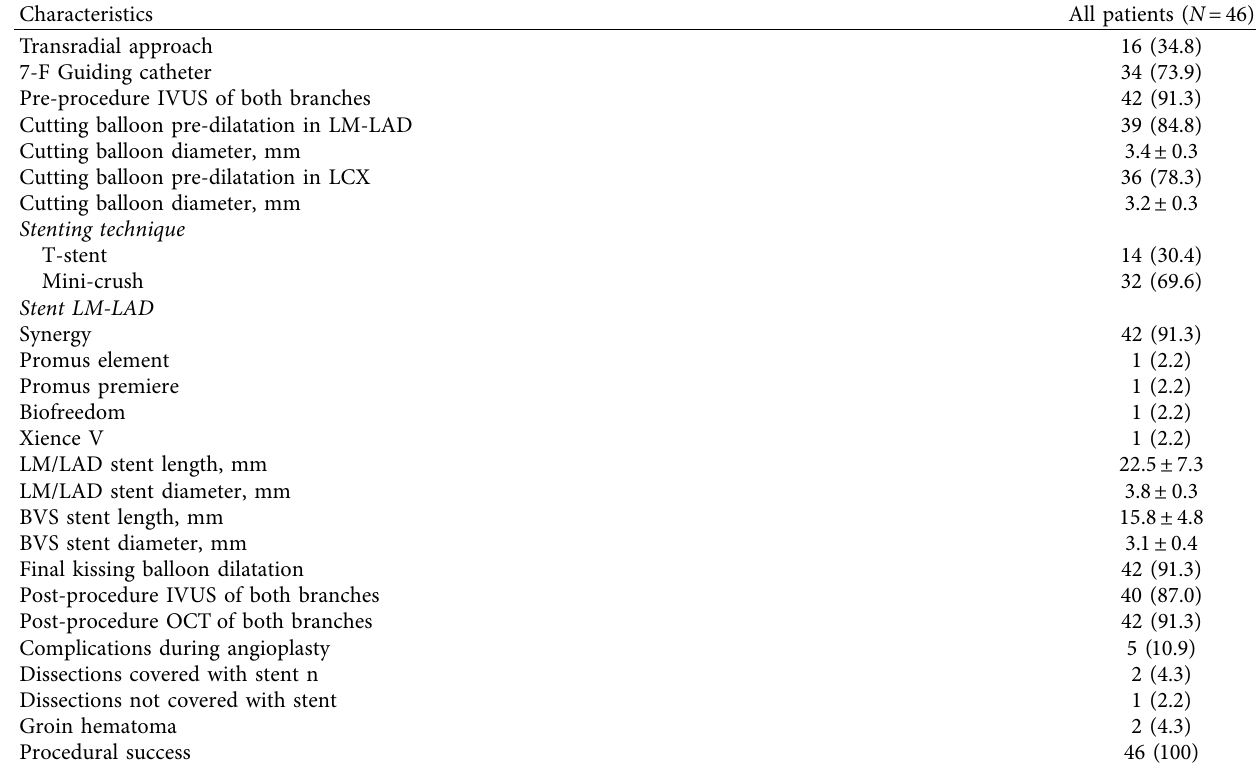
Table 2: Procedural characteristics.